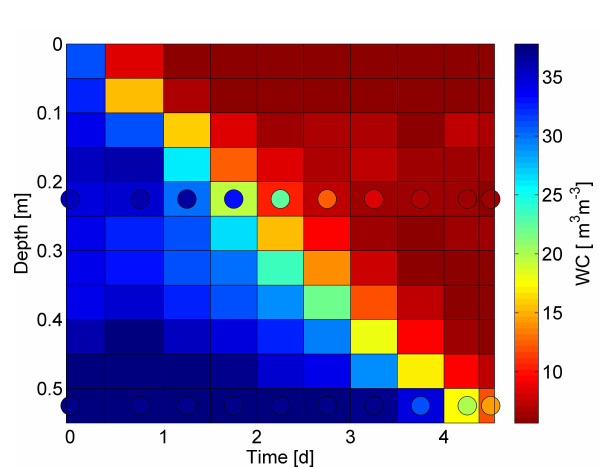
Fig. 6 : Comparison of inverted soil moisture profiles obtained within glass beads with 2 Fig. 6. Comparison of inverted soil moisture profiles obtained independent soil moisture measurements by means of THETA probes (marked with circles). 3 within glass beads with independent soil moisture measurements by The colour coding is the same for both data sets. 4 means of THETA probes (marked with circles). The colour coding is the same for both data